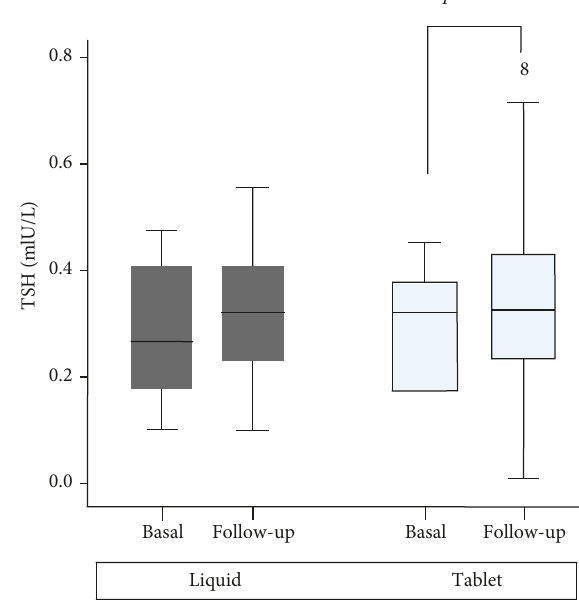
Figure 1: TSH values at fi rst check-up (i.e., 8 – 12 months after 131 I remnant ablation) and at follow-up (i.e., after 12 months from fi rst check-up) in patients taking tablets and/or liquid L-T4